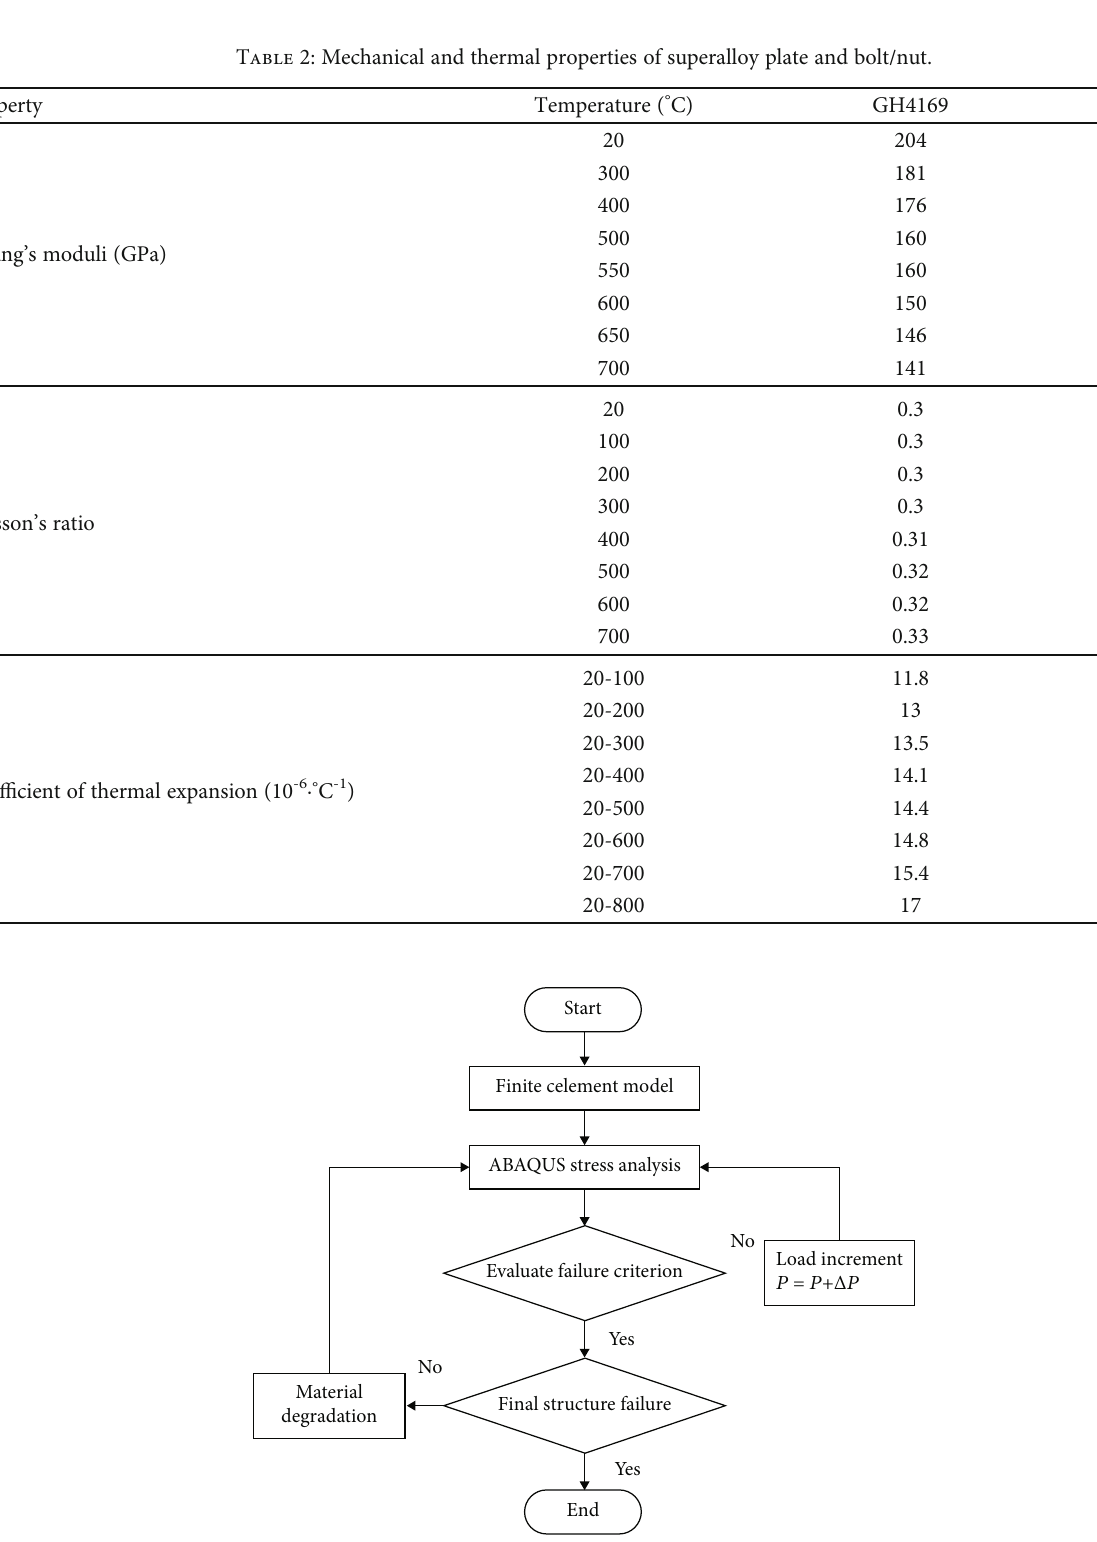
Figure 3: Flowchart for progressive damage analysis of the hybrid